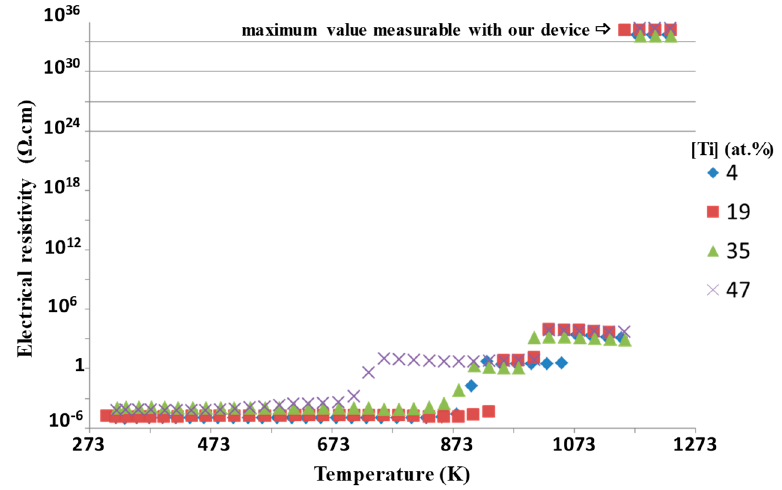
Figure 4. Resistivity measurements of different Pt–Ti coatings as a function of the temperature and for four Ti concentrations.